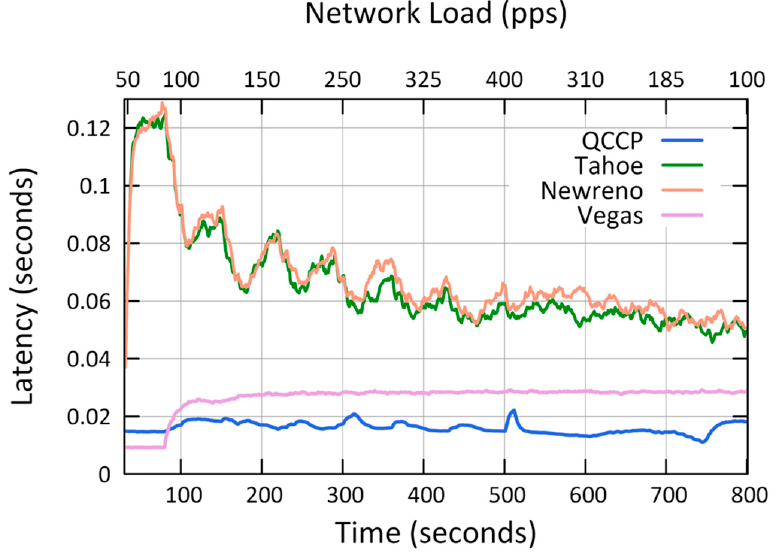
Figure 10. Comparison of average packet transmission latency (L).